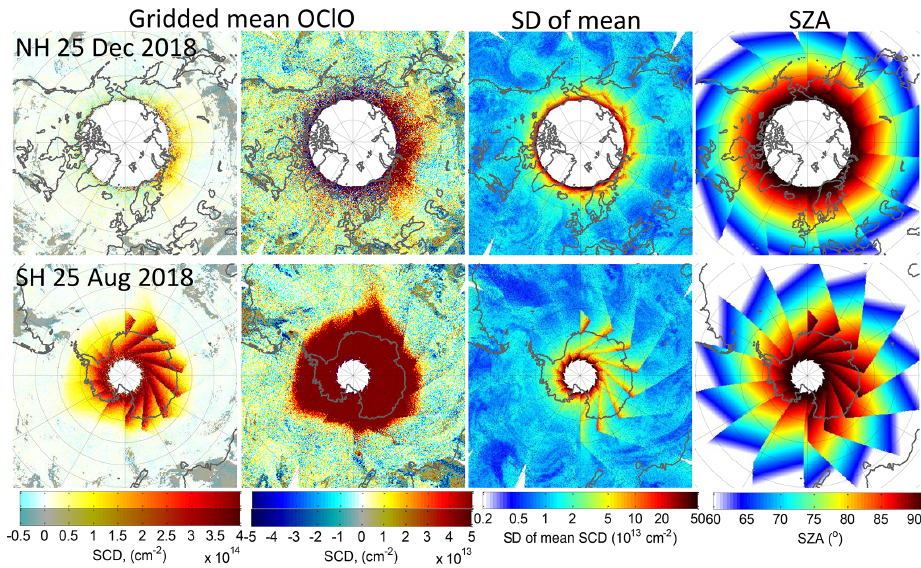
Figure 3. Left plots: OClO SCDs for 25 December 2018 in the NH (top) and 25 August 2018 in the SH (bottom) binned on a 0 . 2 ◦ × 0 . 2 ◦ grid in terms of an equidistant in latitude coordinate projection. Areas with cloud fraction (CF) below 5% are shaded. Second column from left: same results but with a different colour scale. Second from right: standard deviation of the binned mean. Right: SZA of the plotted data.